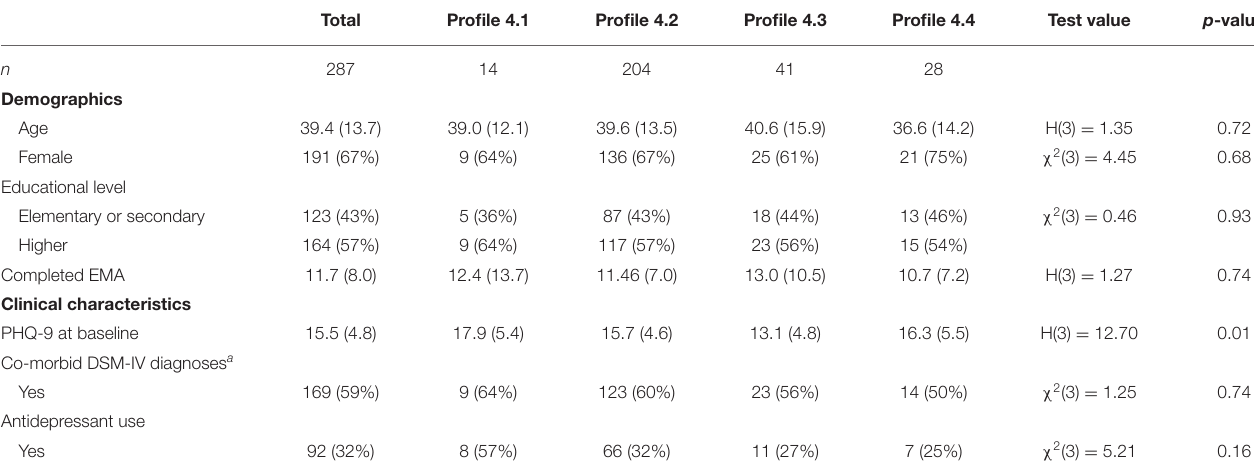
TABLE 3 | Descriptive statistics for the demographic and clinical characteristics of the best fitting